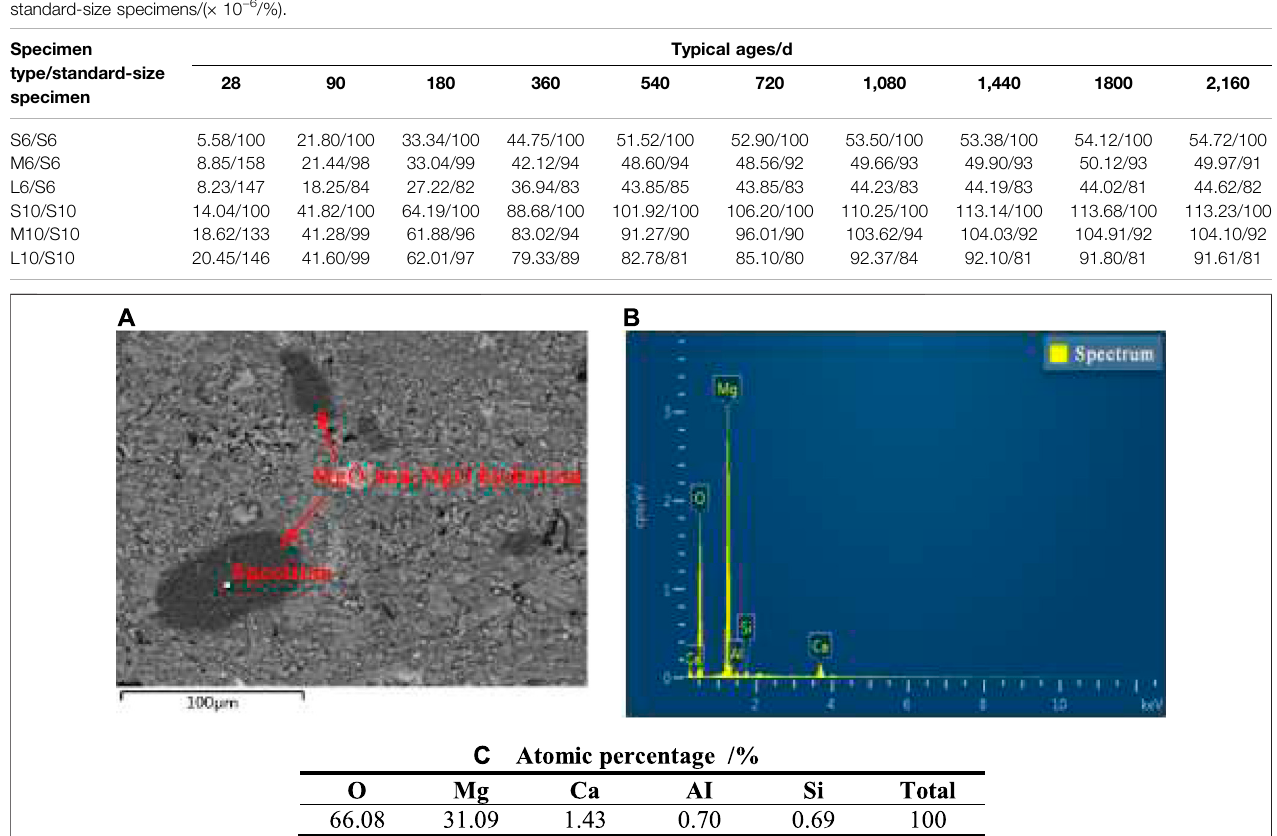
FIGURE 6 | Energy spectrum analysis diagram of a standard-size concrete specimen mixed with 10% MgO. (A) Backscattered electron image. (B) Micro-area composition of energy spectrum. (C) Atomic percentage.